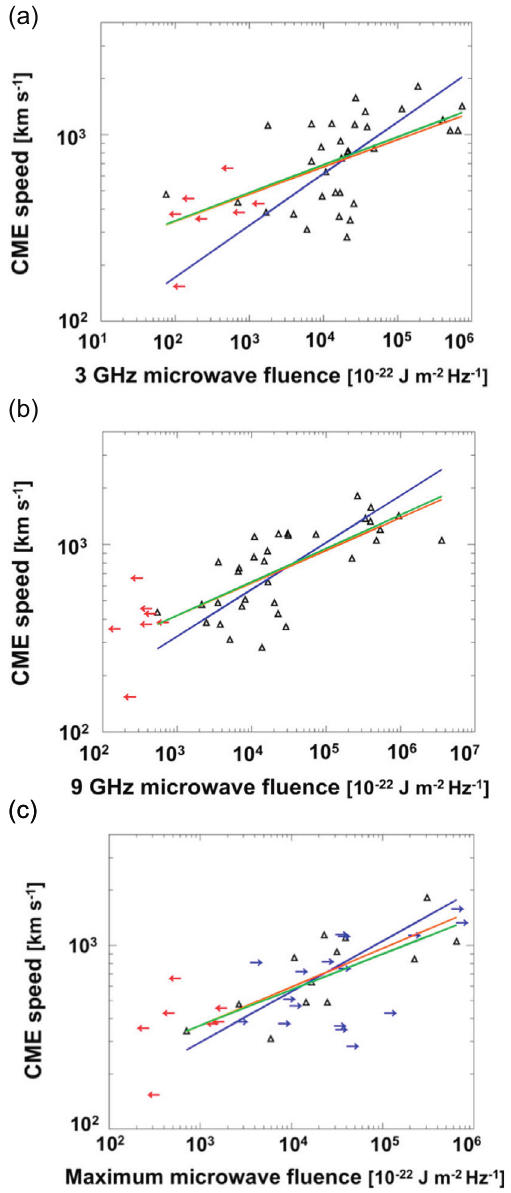
Fig. 3. Scatter plots for limb-CME speed over the period 1998–2014 versus the microwave fluences: (a) / 3 GHz , (b) / 9 GHz and (c) / max . The solid coloured lines represent the linear fits obtained by different methods: least absolute deviation (green), least squares (orange) and total least squares (blue). Red arrows show upper limits of the fluences, blue arrows the lower limits of / max